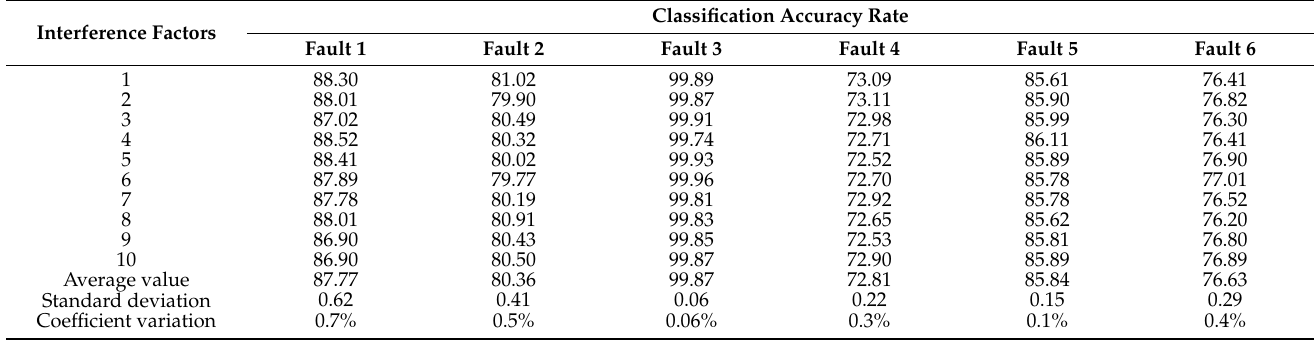
Table 5. Accuracy rate